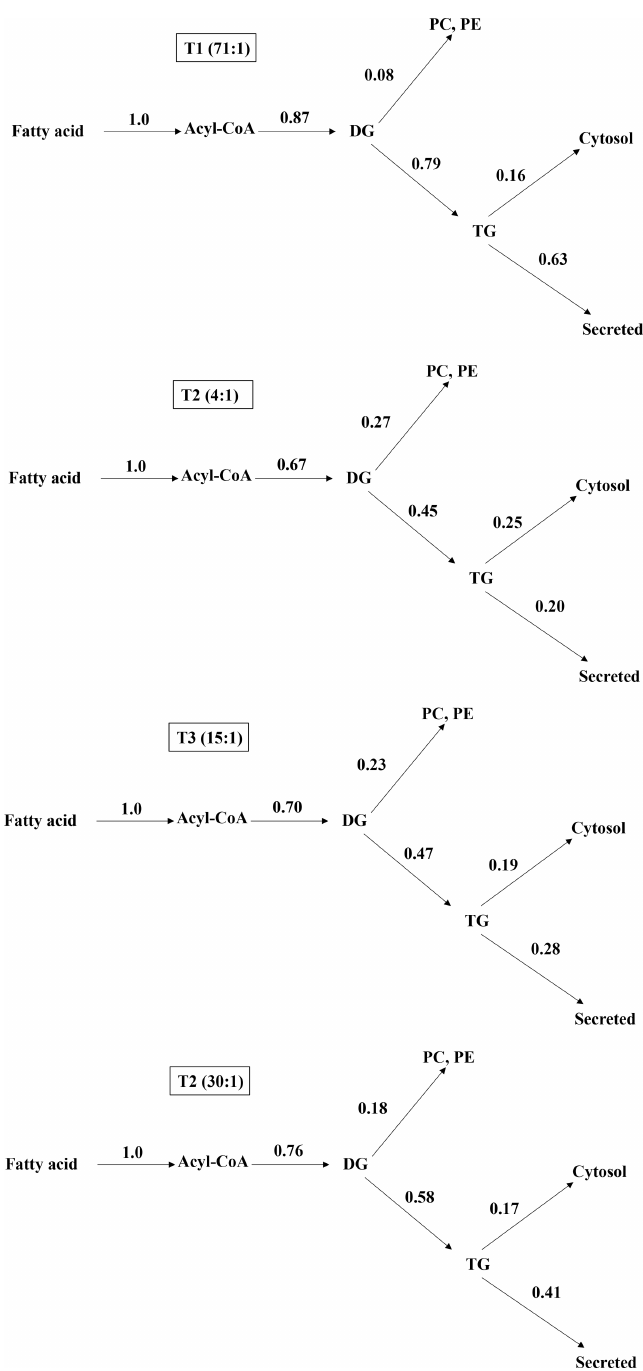
Figure 1. Distribution of acyl moiety fluxes for oxidation and glycerolipid synthesis in the liver of jugular-vein-cannulated rats ( n = 6). DG, diacylglycerol; TG, triglyceride; PC, phosphatidylcholine; PE,